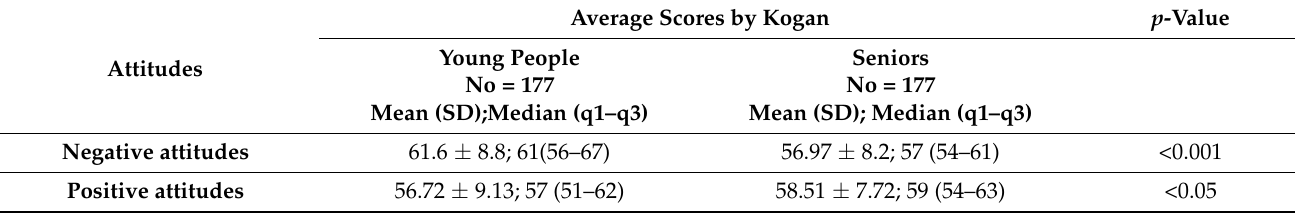
Table 4. The attitudes of respondents towards the older adults according to the Kogan scale. Average Scores by Kogan p Attitudes